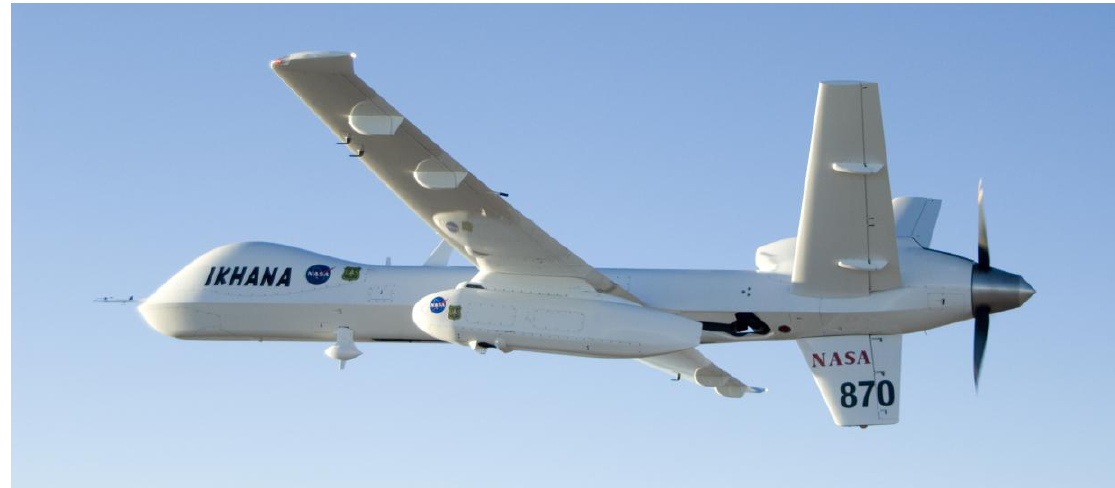
Figure 8. NASA Ikhana. Image courtesy